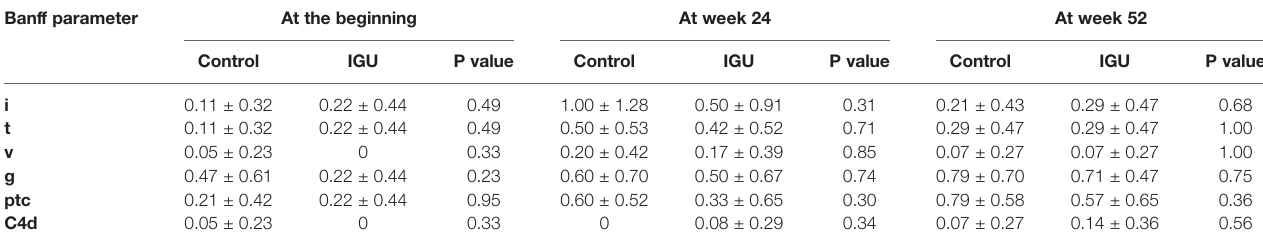
TABLE 3 | Comparison of detailed pathological parameter between two groups according to Banff 2017 criteria. Banff parameter At the beginning At week 24 At week 52 Control IGU P value Control IGU P value Control